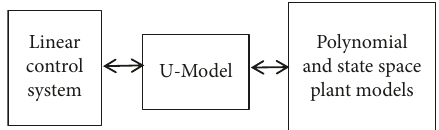
Figure 1: U-Model-based control system